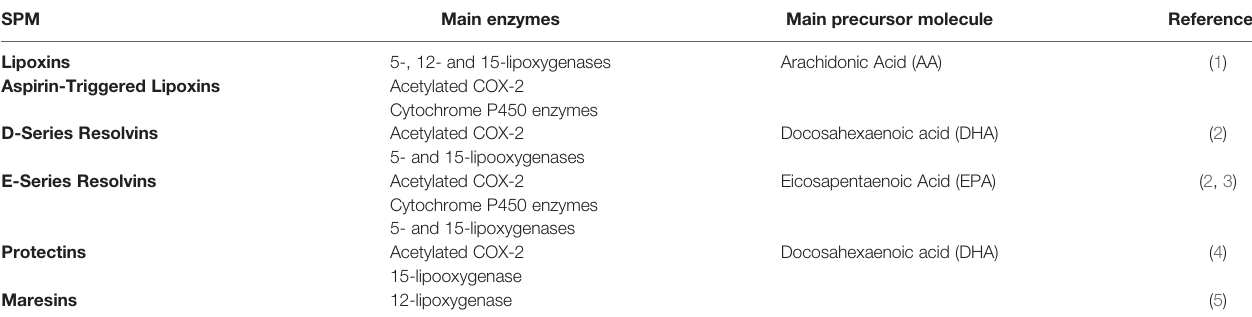
TABLE 1 | Classi fi cation of principal specialized pro-resolving lipid